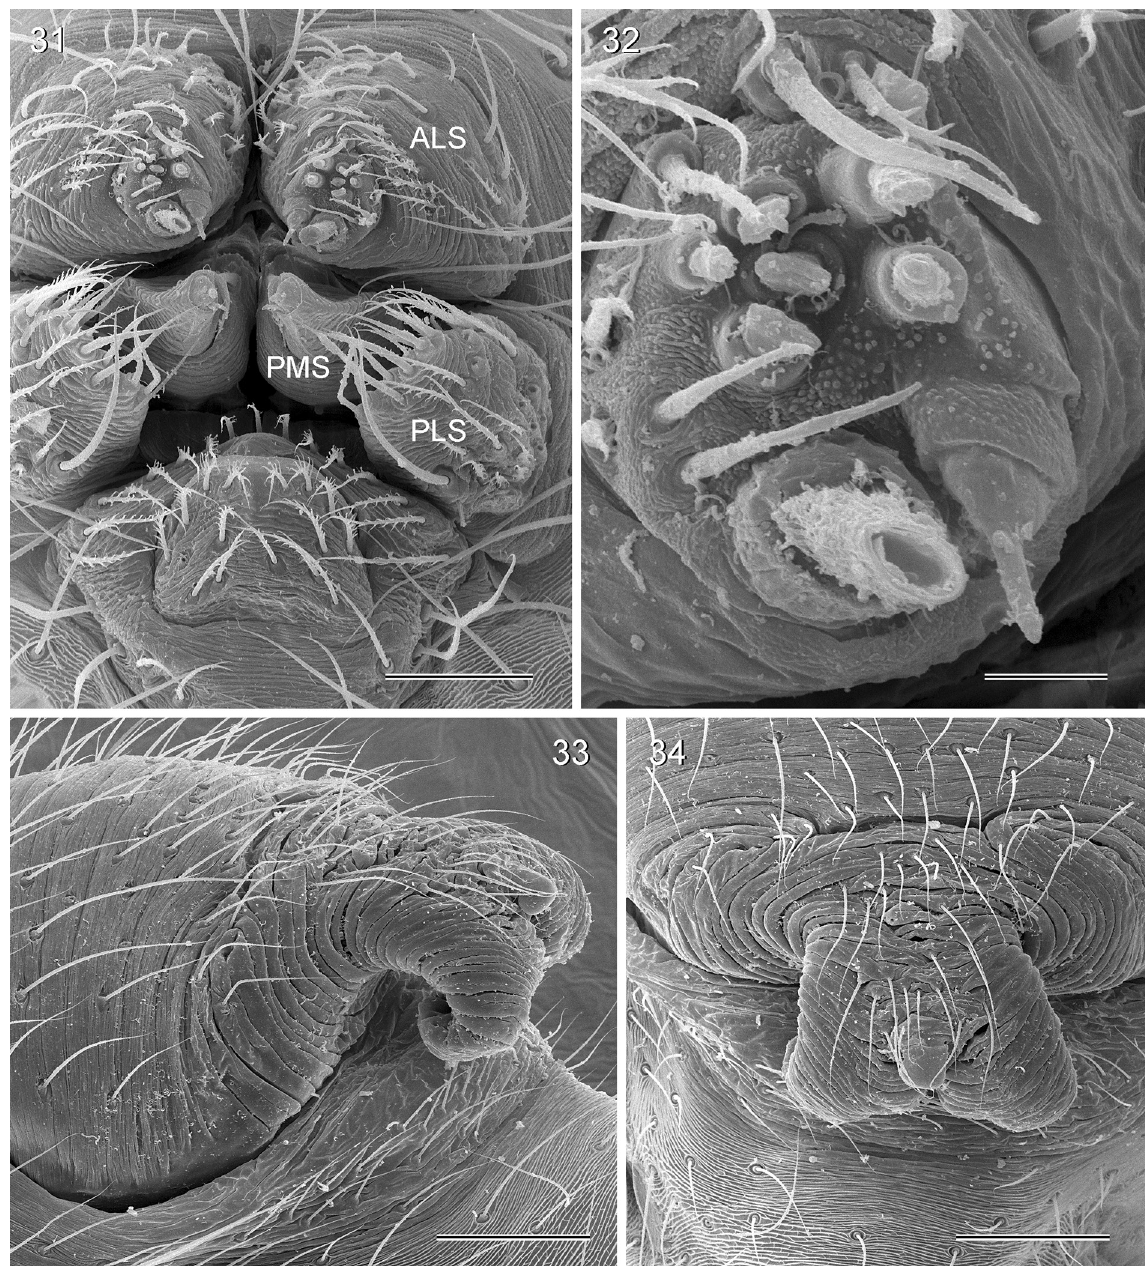
Figs 31–34. Panjange casaroro Huber sp. nov., SEM micrographs (ZFMK, Ar 13001). 31 . Female spinnerets. 32 . Female ALS. 33–34 . Epigynum and scape. 33 . Lateral (slightly posterior) view. 34 . Ventral view. Abbreviations: ALS, anterior lateral spinneret; PLS = posterior lateral spinneret; PMS = posterior median spinneret. Scale bars: 31 = 60 µm; 32 = 10 µm; 33–34 = 100